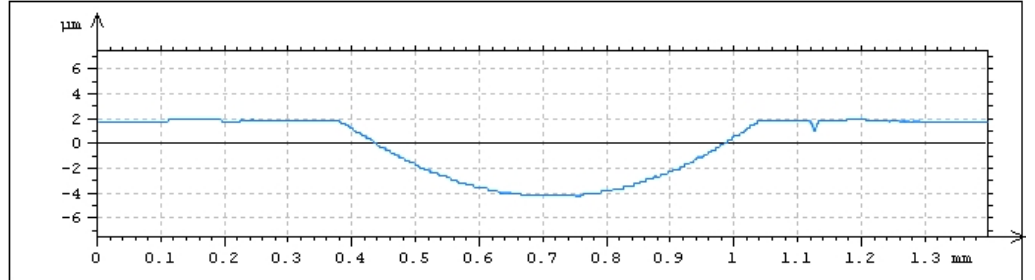
Figure 7. Profile with oil pocket made by abrasive jet machining.